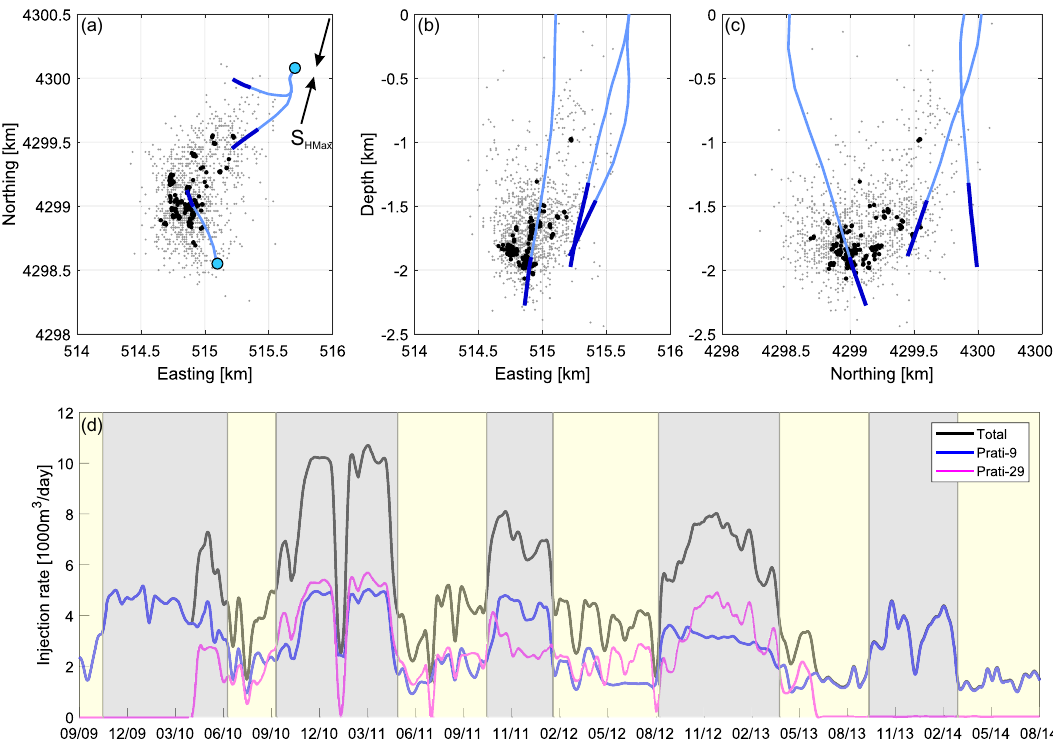
Figure 1. ( a – c ) Original localizations of 1179 catalog events (gray) and localizations of 158 multiple events after double-difference relocation (black). Trajectories of injection wells are marked with blue and their open hole sections with dark blue. ( d ) Injection rates into Prati-9 (blue), Prati-29 (magenta) and both wells (black) in time. Distinguished high and low injection rate periods are marked with gray and yellow,